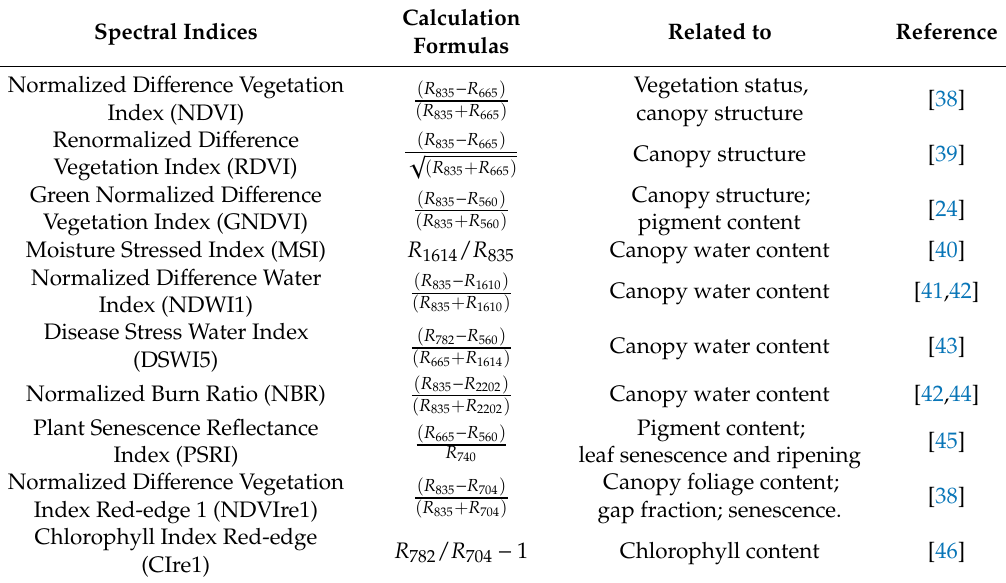
Table 2. Spectral indices used for the identification of cotton root rot in this study.